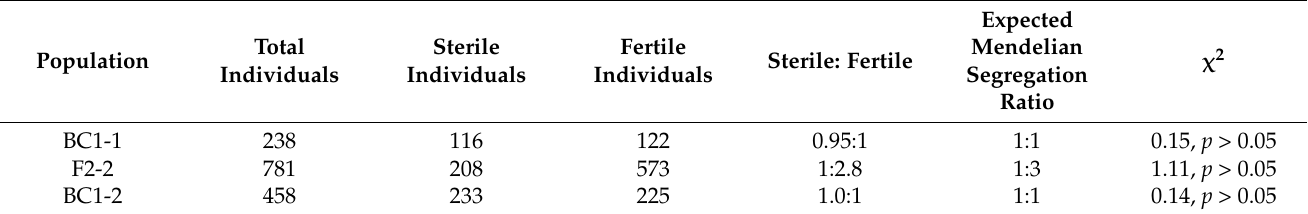
Table 2. Genetic analysis of inheritance sterility/fertility characters in rapeseed lines.